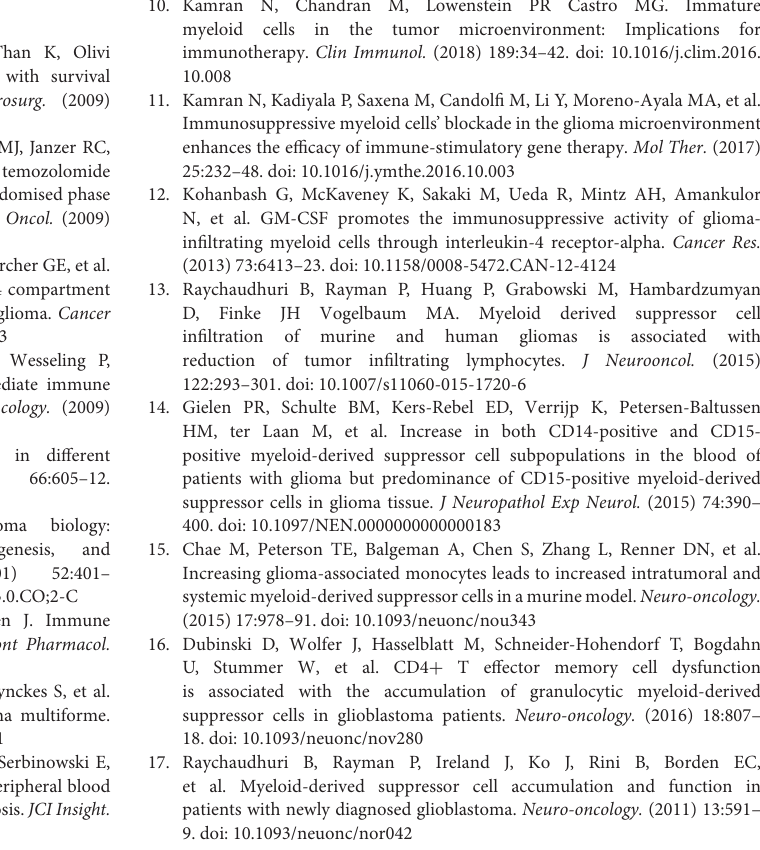
performed in GraphPad Prism using Log-rank (Mantel-Cox) test for p value and hazard ratio log rank was computed on the same data using GraphPad Prism. Supplemental Figure 2 | Intracrainially injected tumors vehicle vs ibudilast treated tumors, non-tumor tissue, and blood analysis from Figure 5 demonstrate no significant difference in M-MDSCs, G-MDSCs, Macrophages, or Microglia (A–D) . Two-Tailed T -Test was performed for comparing vehicle vs. ibudilast in each compartment ∗ <0.05, ∗∗ <0.01, ∗∗∗ <0.001. Supplemental Figure 3 | Intracrainially injected tumors vehicle vs ibudilast treated tumors, non-tumor tissue, and blood analysis from Figure 5 demonstrate no significant difference in total CD45 + cells, CD4T cells, ratio of CD8/ CD4T cells, or NK cells (A–D) . CD74 expression was analyzed on vehicle and Ibudilast treated M-MDSCs demonstrating an increase in CD74 protein expression on the cell surface of M-MDSCs upon treatment in the tumor compartment only (E) . Two-Tailed T -Test was performed for comparing vehicle vs. ibudilast in each compartment ∗ <0.05, ∗∗ <0.01, ∗∗∗ <0.001. Supplemental Figure 4 | Intracrainially injected tumors vehicle vs ibudilast treated mice were perfused at endpoint and tissue was paraffin embedded for IHC analysis. Staining for p-Histone3 and Ki67 demonstrated a reduction in proliferation in the ibudilast treated tumors. Two-Tailed T -Test was performed for comparing vehicle (mock) vs. ibudilast treated tumors ∗ <0.05, ∗∗ <0.01, ∗∗∗